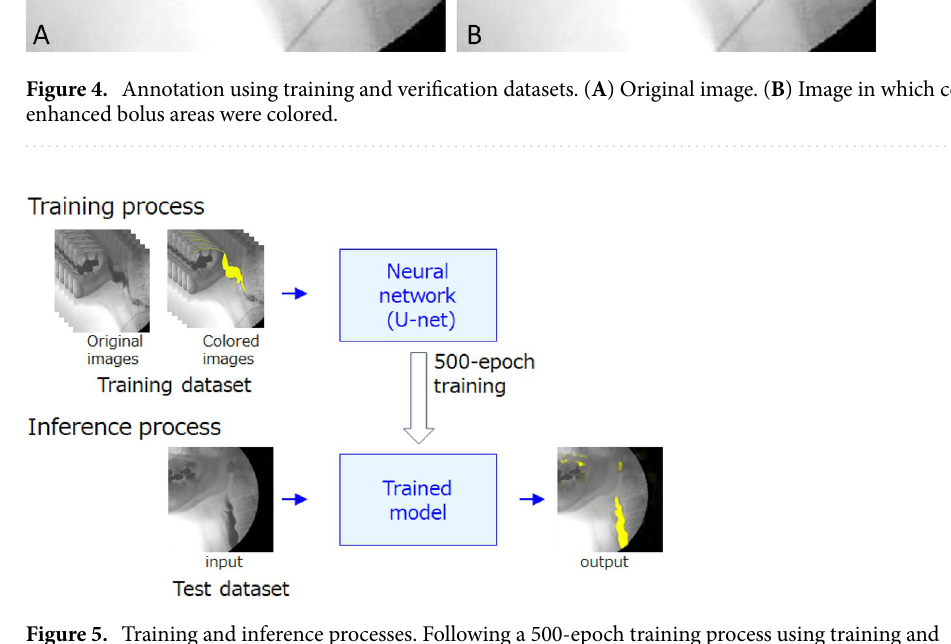
Figure 5. Training and inference processes. Following a 500-epoch training process using training and validation datasets paired with the original and colored images, a trained model was created. In the inference process, test dataset 1 or 2 was applied to the trained model and the model performance was